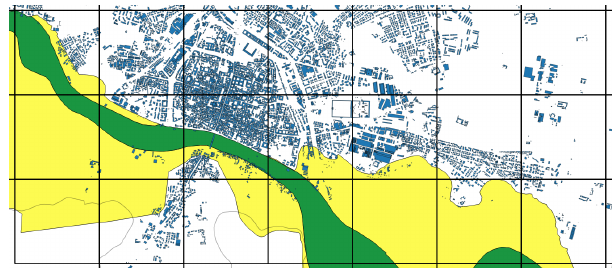
Figure 13. Flood zones A (green) and B (yellow) in the municipal- ity of Pavia, according to the Po River Basin Authority map.